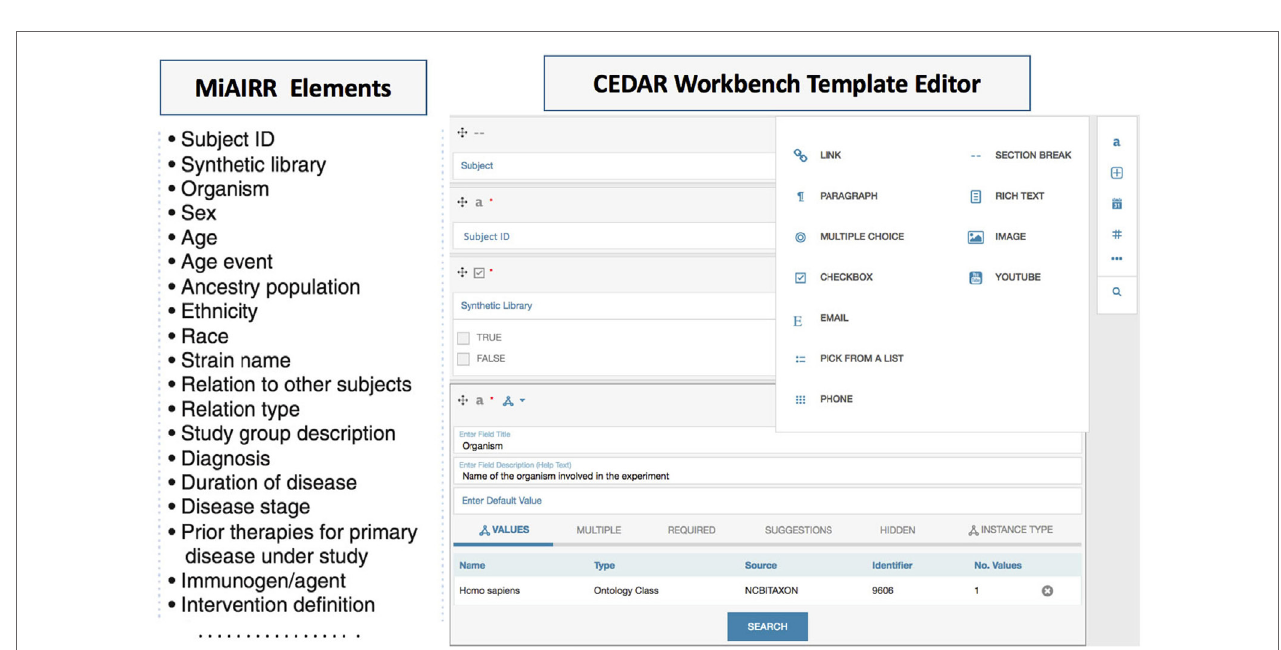
FIgURe 2 | The Minimal Information about an Adaptive Immune Receptor Repertoire (MiAIRR) fields are transformed into a CEDAR template using the CEDAR Template Designer. Fields specified by MiAIRR (left panel) are transformed into a CEDAR template (right panel).